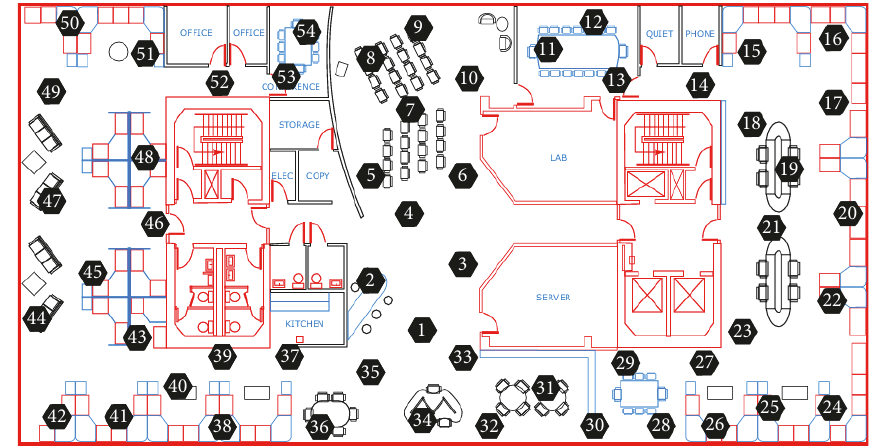
Figure 2: Location of sensor nodes deployed in IBRL